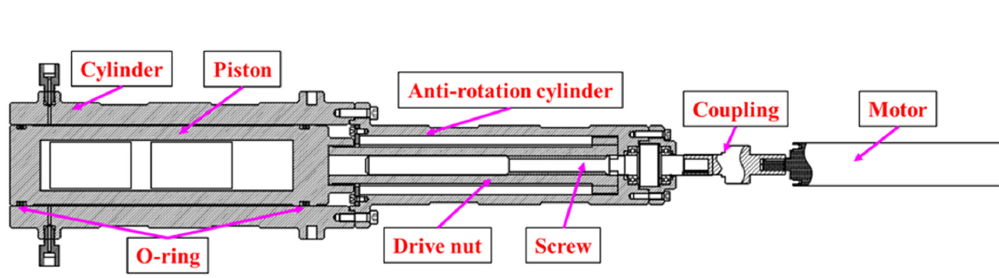
Figure 9. Mechanical model of the friction test.